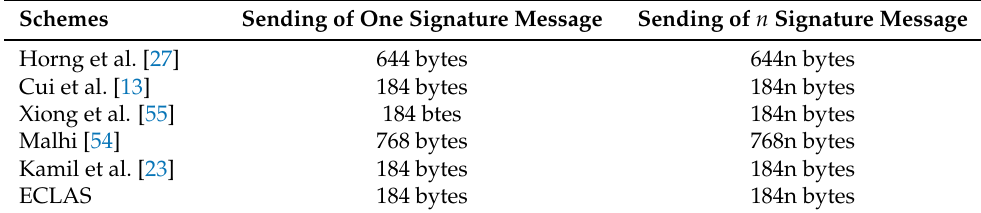
Table 5. Communication Overhead